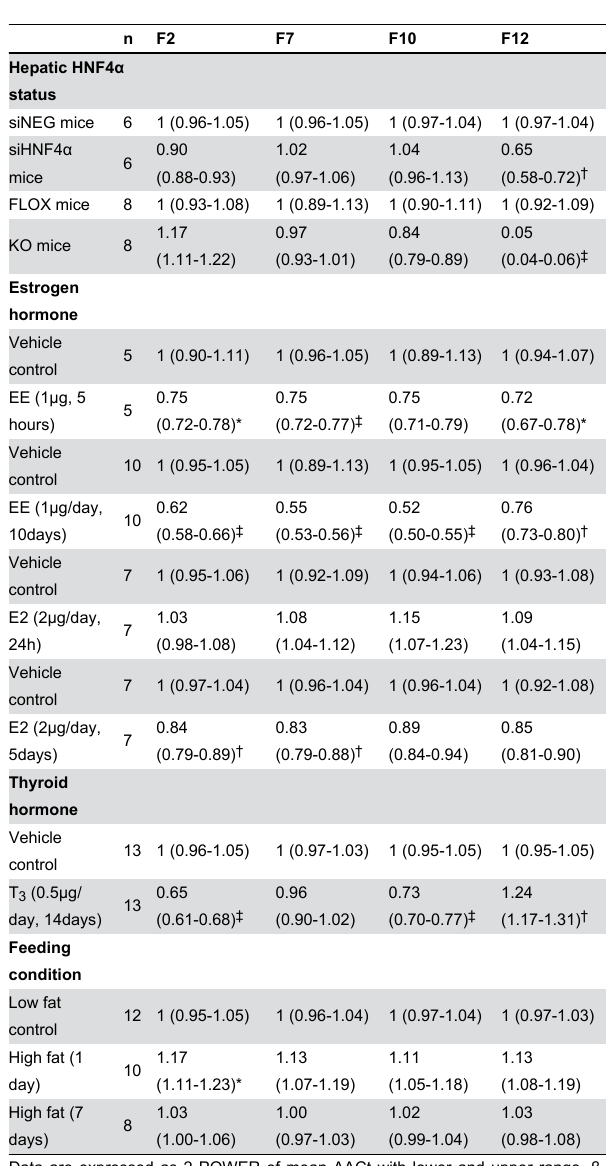
Table 2. Correlation between transcript levels of F11 , Klkb1 and Cyp4v3 in livers of challenged mice.